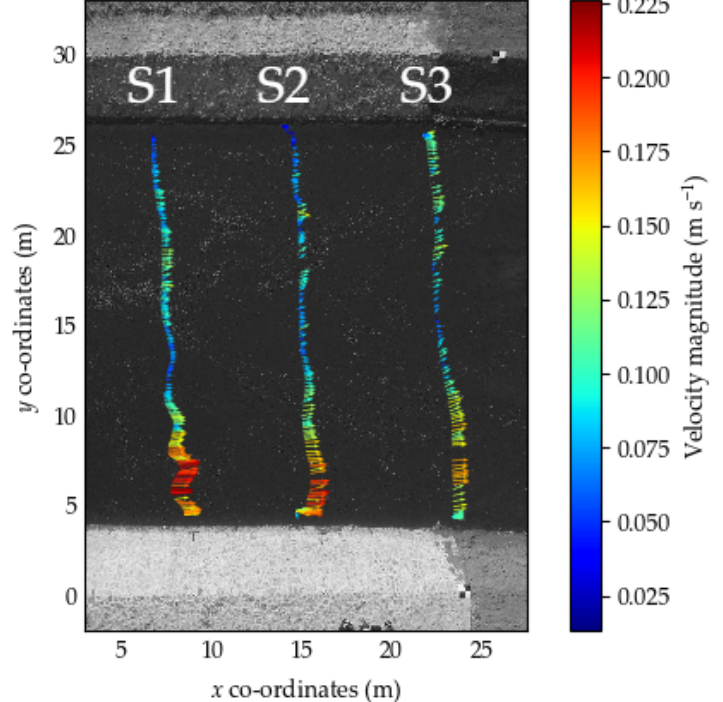
Figure 6. Quiver plot of the ROI, showing velocity magnitudes and directions for Sections 1–3 (left to